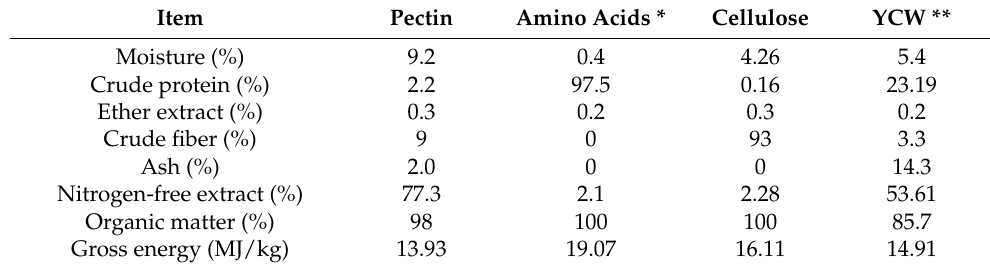
Table 2. Chemical composition of fermentation substrates used in vitro.